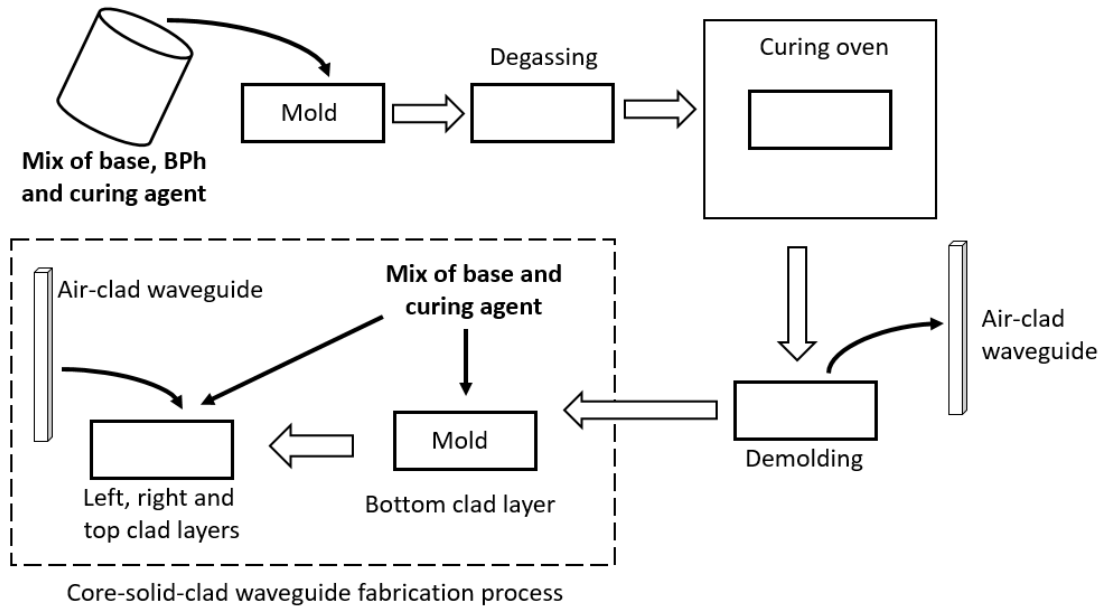
Figure 2. Waveguides manufacturing steps.